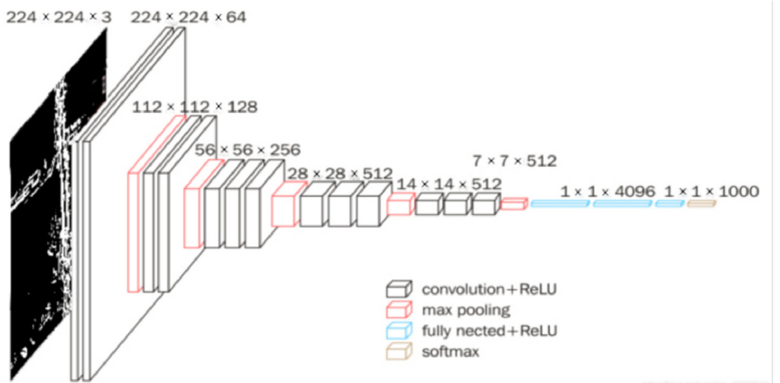
Figure 12. VGG16 framework structures.